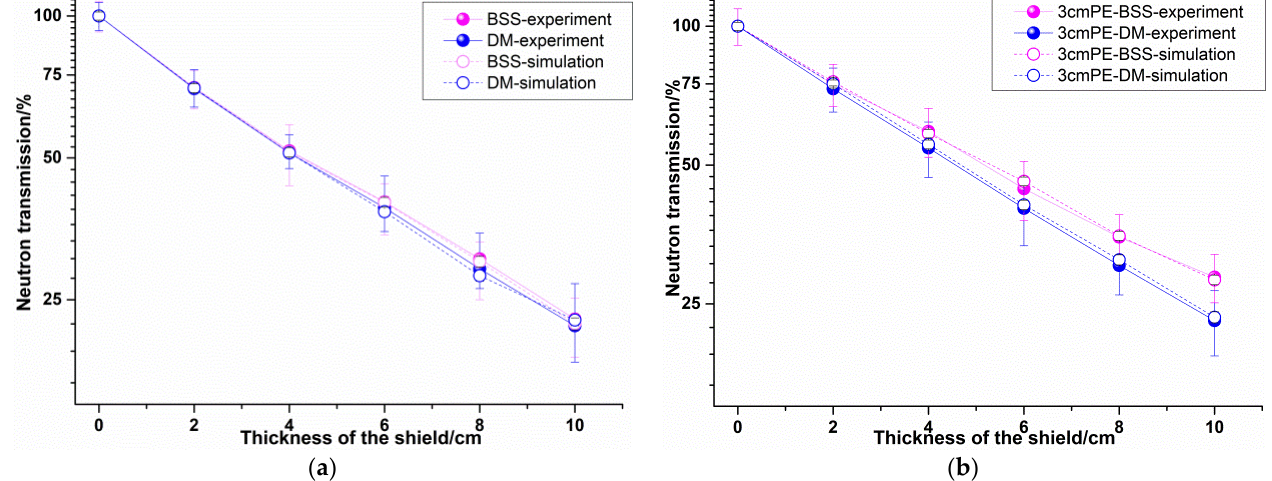
Figure 8. Neutron transmission experiment and simulation results. ( a ) Results of the condition without a polyethylene moderating layer, ( b ) results of the condition with a 3 cm polyethylene moderating layer.